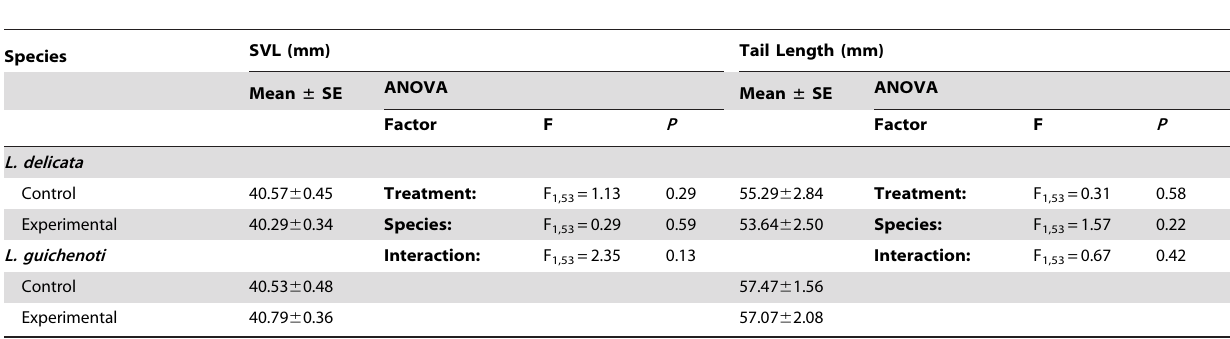
Table 1. Body size (snout-vent length, SVL) and tail length of the Lampropholis delicata and L. guichenoti assigned to the control and experimental groups.